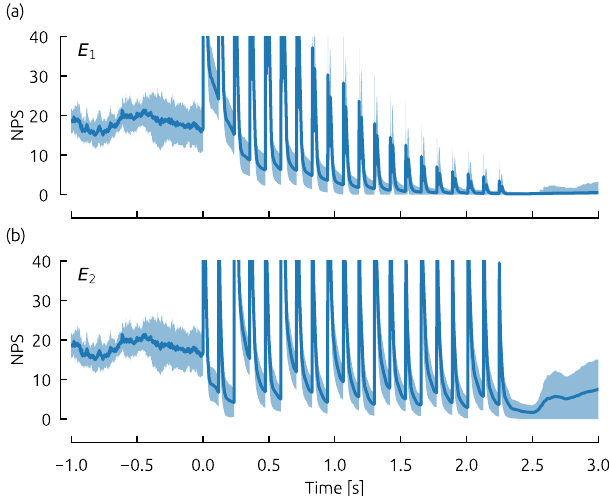
Figure 5. The temporal evolution of the number of phase singularities (NPS) as a measure for the number of spiral waves in the system during a ten pulse protocol. For the Fenton-Karma model (FK), two pulse amplitudes were selected ( E 1 = 0.3 shown in ( a ) and E 2 = 1.0 shown in ( b )) for a specific pacing frequency of f pacing = 1.1 f dom (marked in Fig. 3 as white crosses). For these cases, the number of phase singularities